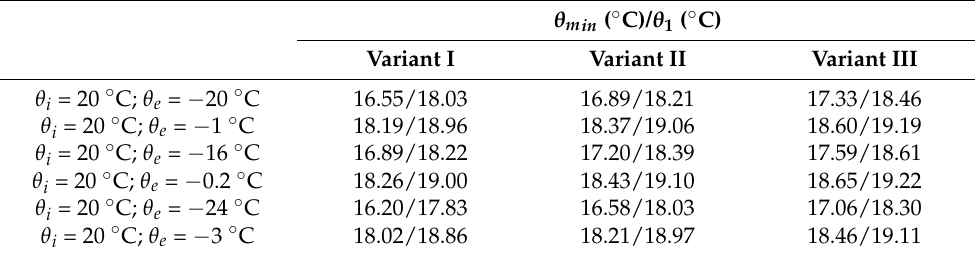
Figure 7. Graphic representation of the simulation results of numerical calculations for the junction of the external wall with the roof: ( a ) Calculation model; ( b ) Heat flux lines; ( c ), ( d ) Temperature distribution. Table 15. Temperature at the junction of the external wall with the roof . Table 14. Temperature at the junction of the external wall with the